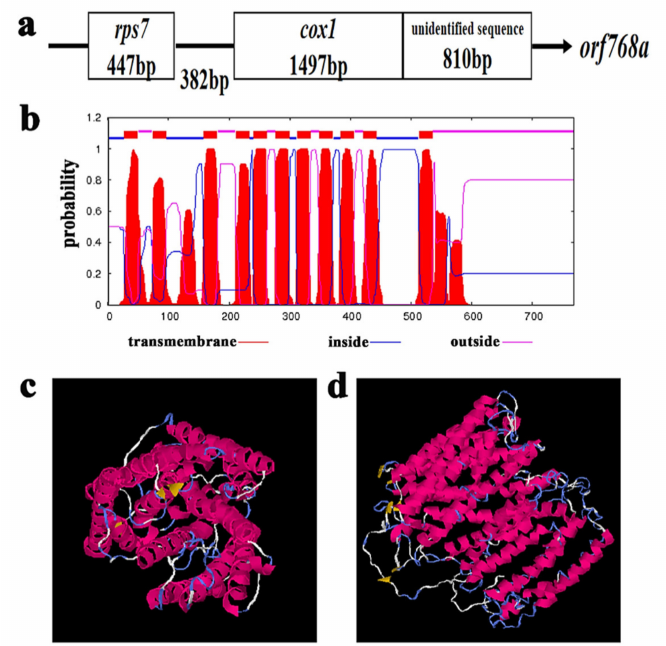
Figure 5. Gene structure of orf768a . ( a ) The orf768a sequence has a chimeric structure including cox1, arrow indicates the 5 (cid:48) -to-3 (cid:48) direction. ( b ) Transmembrane domains of the orf768a gene products. ( c ) Tertiary structure analysis of cox1 . ( d ) Tertiary structure analysis of orf768a